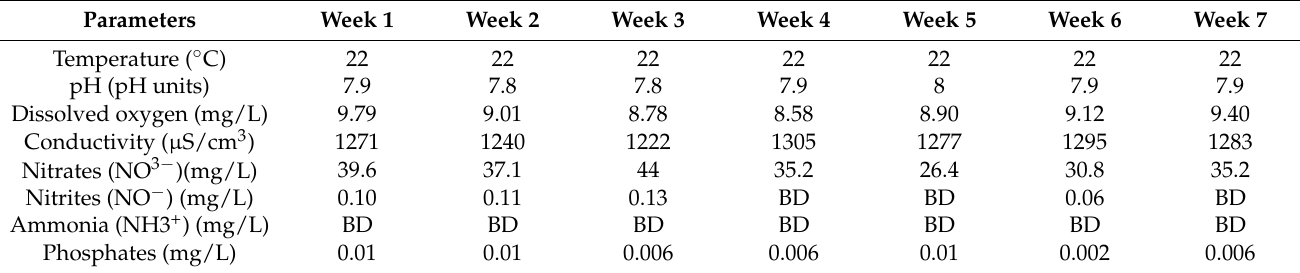
Table 1. Average values of the water parameters in RAS.